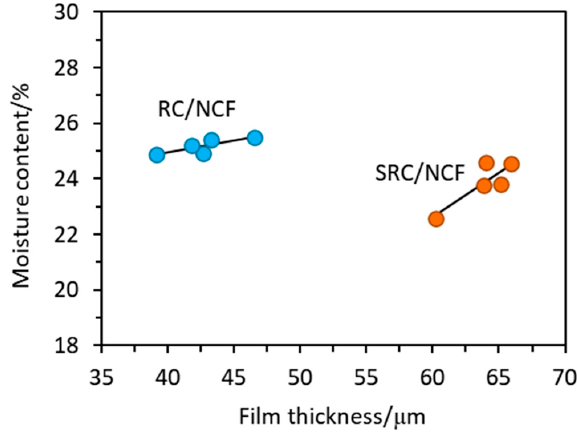
Figure 1. Plots of moisture content against film thickness for the SRC/NCF and RC/NCF films.